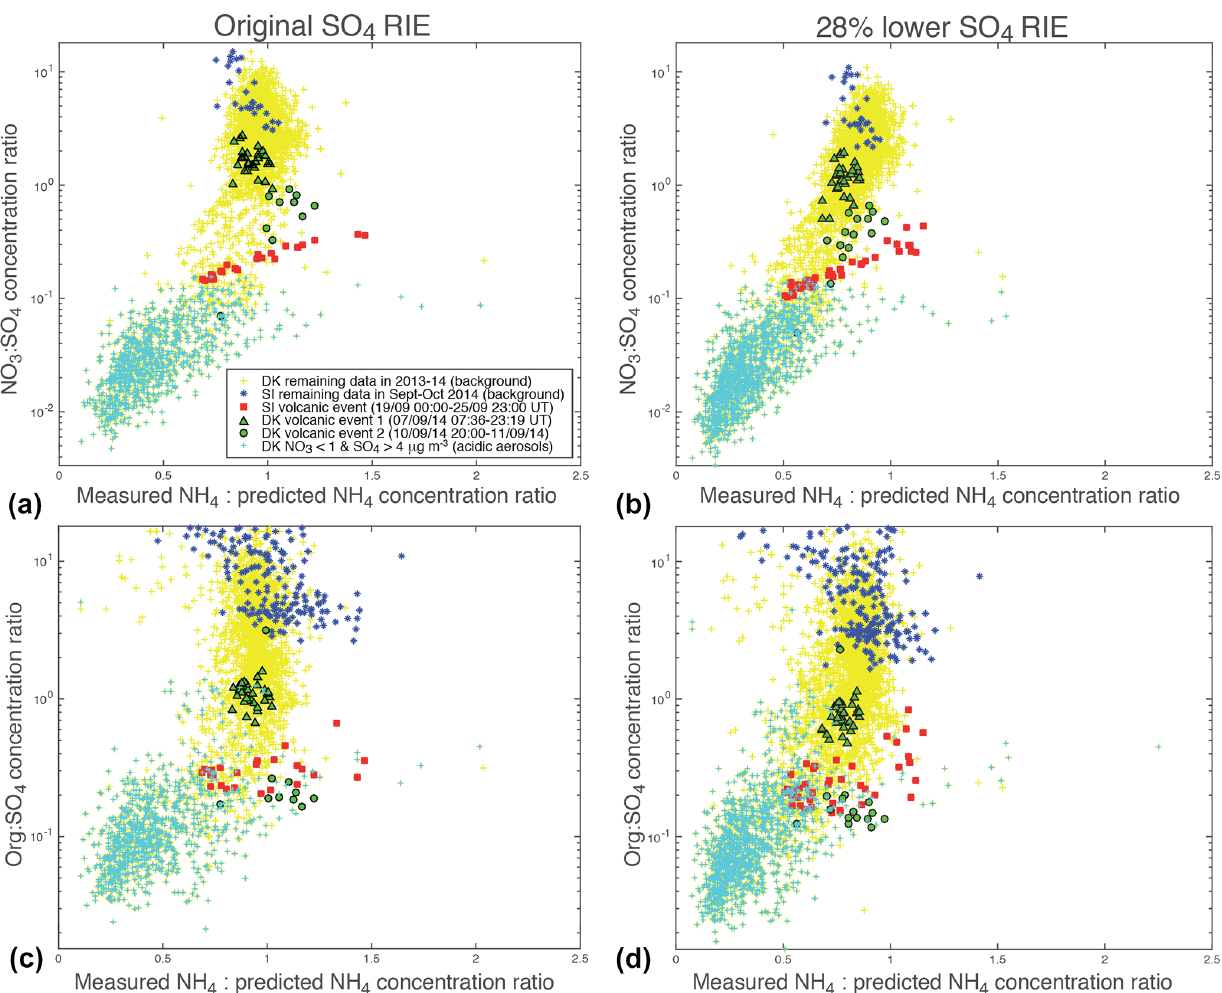
Figure 9. Scatter plots of (a, b) NO 3 : SO 4 or (c, d) Org : SO 4 mass concentration ratios (in logarithmic scale) vs. the ratio of measured to predicted NH 4 mass concentrations for (a, c) original and (b, d) 28% lower sulfate RIE coefficients. Selected ACSM data meeting the p [ p [ criteria (a, b) SO 4 ] 2 +[ NO 3 ] 2 > 6µgm − 3 and (c, d) SO 4 ] 2 +[ Org ] 2 > 6µgm − 3 are